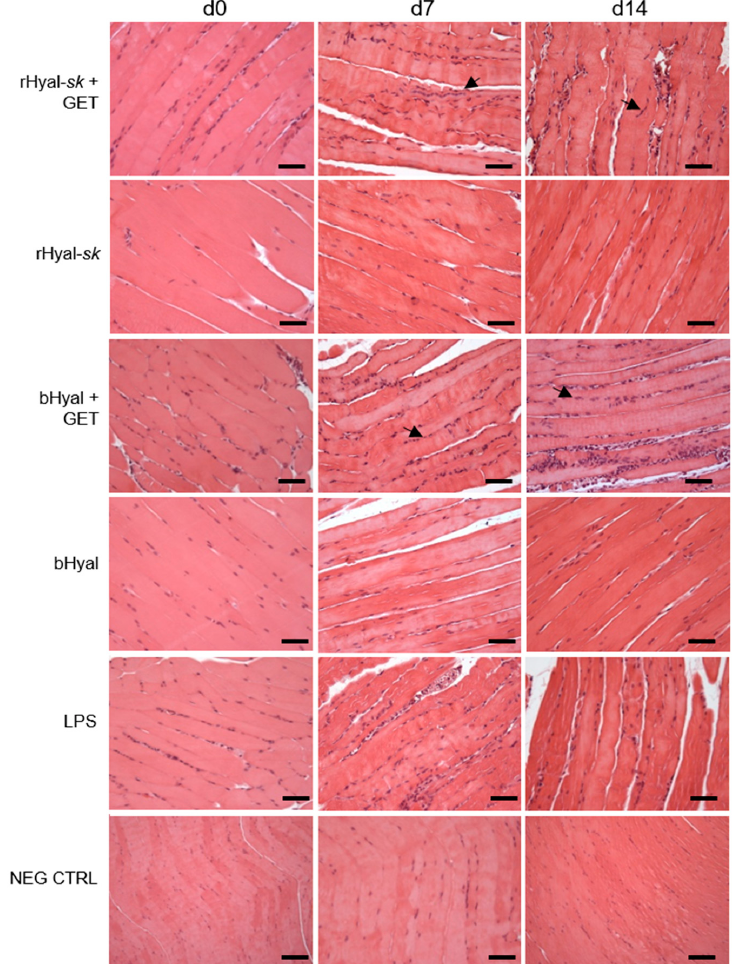
Figure 2. Histological analysis of the morphology and the regenerative process of skeletal muscle after treatment with rHyal- sk in the presence and absence of GET. Paraffin sections of skeletal muscles taken 3 h (d0), d7 and d14 after treatment with rHyal- sk plus GET or rHyal- sk alone are shown. bHyal plus GET or bHyal alone were used as reference muscles. Positive control: muscles injected with LPS. Negative control: untreated muscle. Arrows indicate nuclei of regenerating muscle fibers. 20 × magnification. Scale bars, 50 µ m. rHyal- sk , recombinant Hyal from Fidia Farmaceutici; bHyal, bovine Hyal from Sigma-Aldrich (St. Louis, MO, USA); Hyal + GET, electrotransfer after Hyal injection; LPS, lipopolysaccharide injection; NEG CTRL, untreated